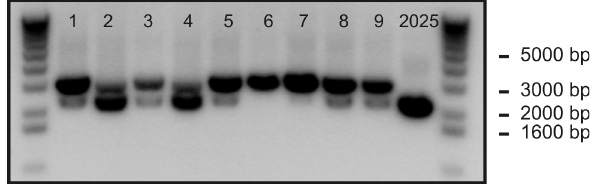
Figure 2. Analysis of genomic DNA of Solfolobus solfataricus cells derived from selected blue colonies from cells electroporated with pSVA37 on tryptone plates. The PCRs were performed with genomic DNA derived from nine individual cultures and from PBL2025 con- trol cells. The primer set used is directed toward the targeted gene flanking regions and resulted in a 2100 bp product in the wild type cells corresponding to the undisrupted gene, and a 2900 bp band for the mutant cells corresponding to the disrupted gene with an insertion of the lacS selection